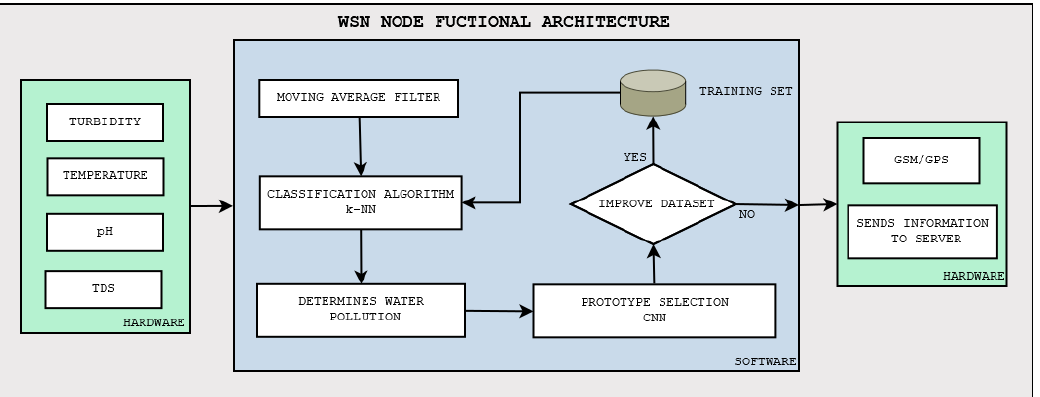
Figure 7. WSN node functional architecture incorporating the workflow of the in-situ data analysis and processing and mainly consisting in filtering, prototype selection and